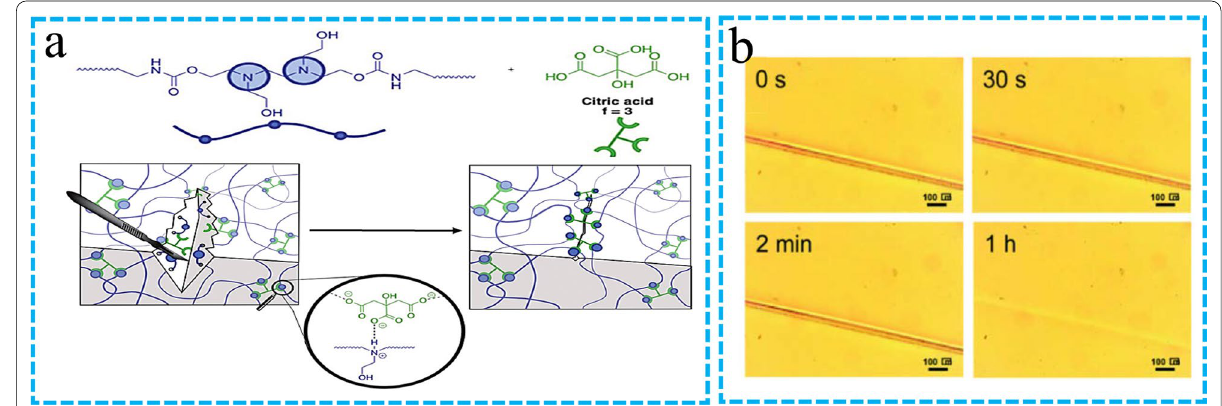
Fig. 11 a Healing mechanism of the sample based on ionic bonds. b Evolution of crack healing Process. Reprinted with permission